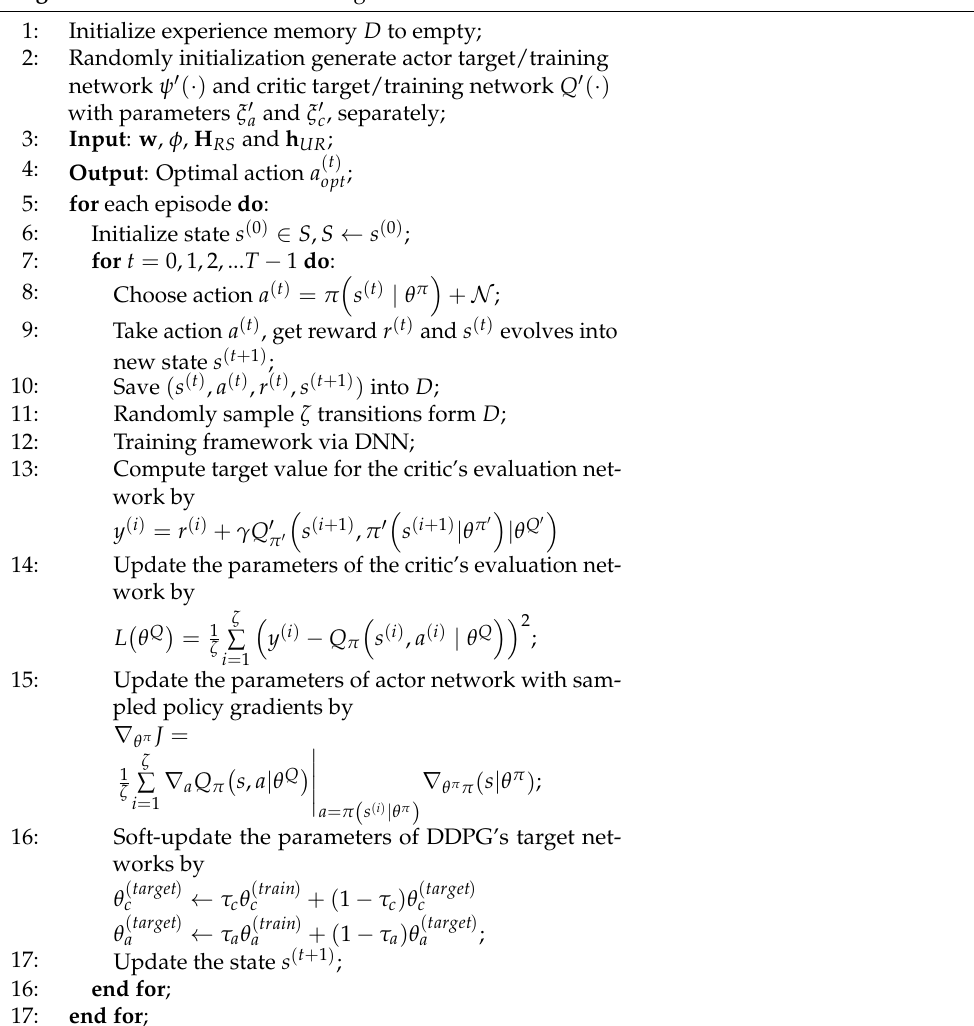
Algorithm 1: Soft-DDPG-based